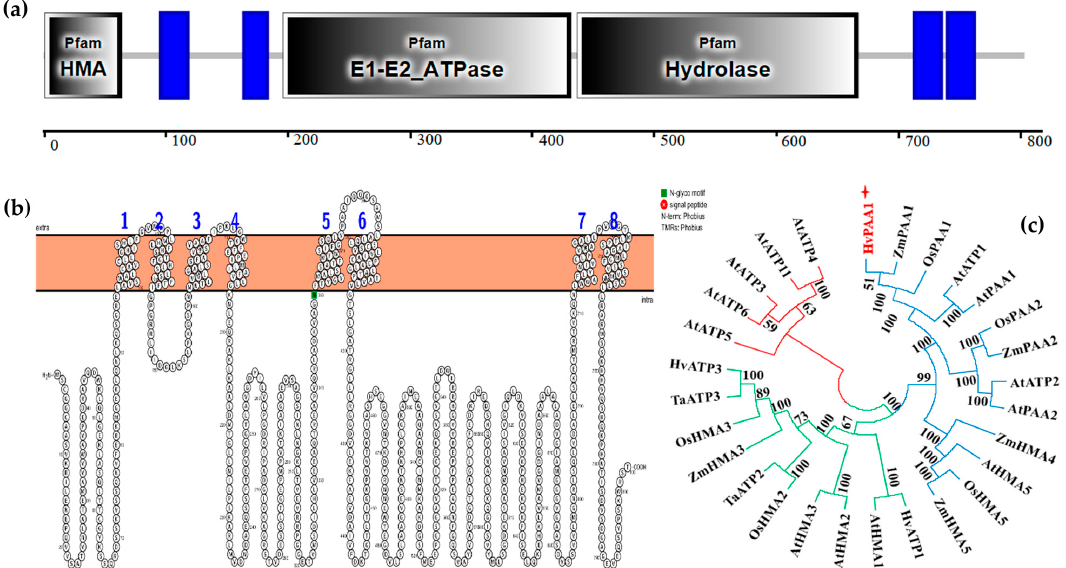
Figure 4. Protein structure and phylogenetic analysis of HvPAA1. ( a ) Amino acid sequence analysis based on the SMATR database. Some features and domains are not shown due to overlap with other annotations. ( b ) Amino acid sequence analysis based on the Protter database. ( c ) Phylogenetic tree constructed in MEGA7 using the neighbor-joining algorithm analysis method.